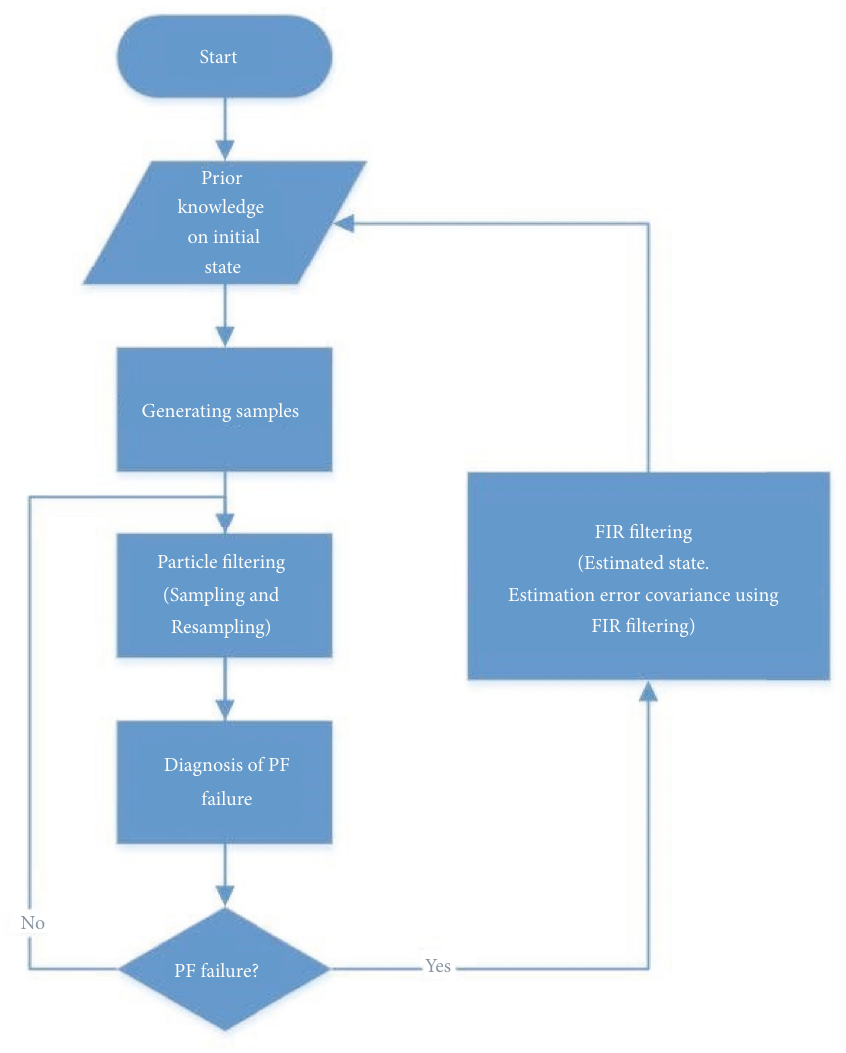
Figure 1: Flowchart of hybrid particle/FIR filtering algorithm